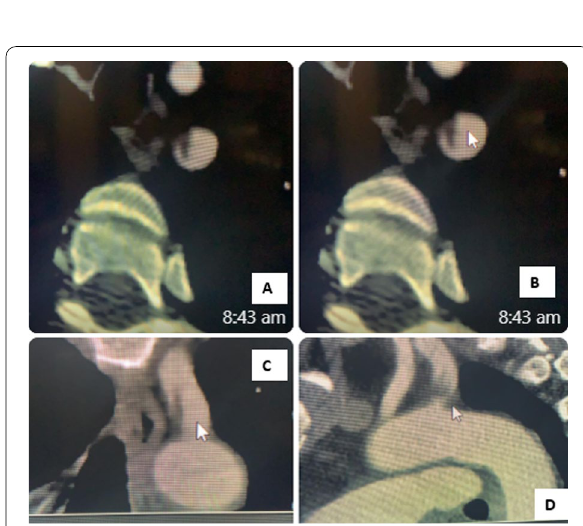
Fig. 3 Multi-slice CT angiography A and B axial, C coronal and D sagittal images that demonstrate a dissection flab at the origin of left subclavian